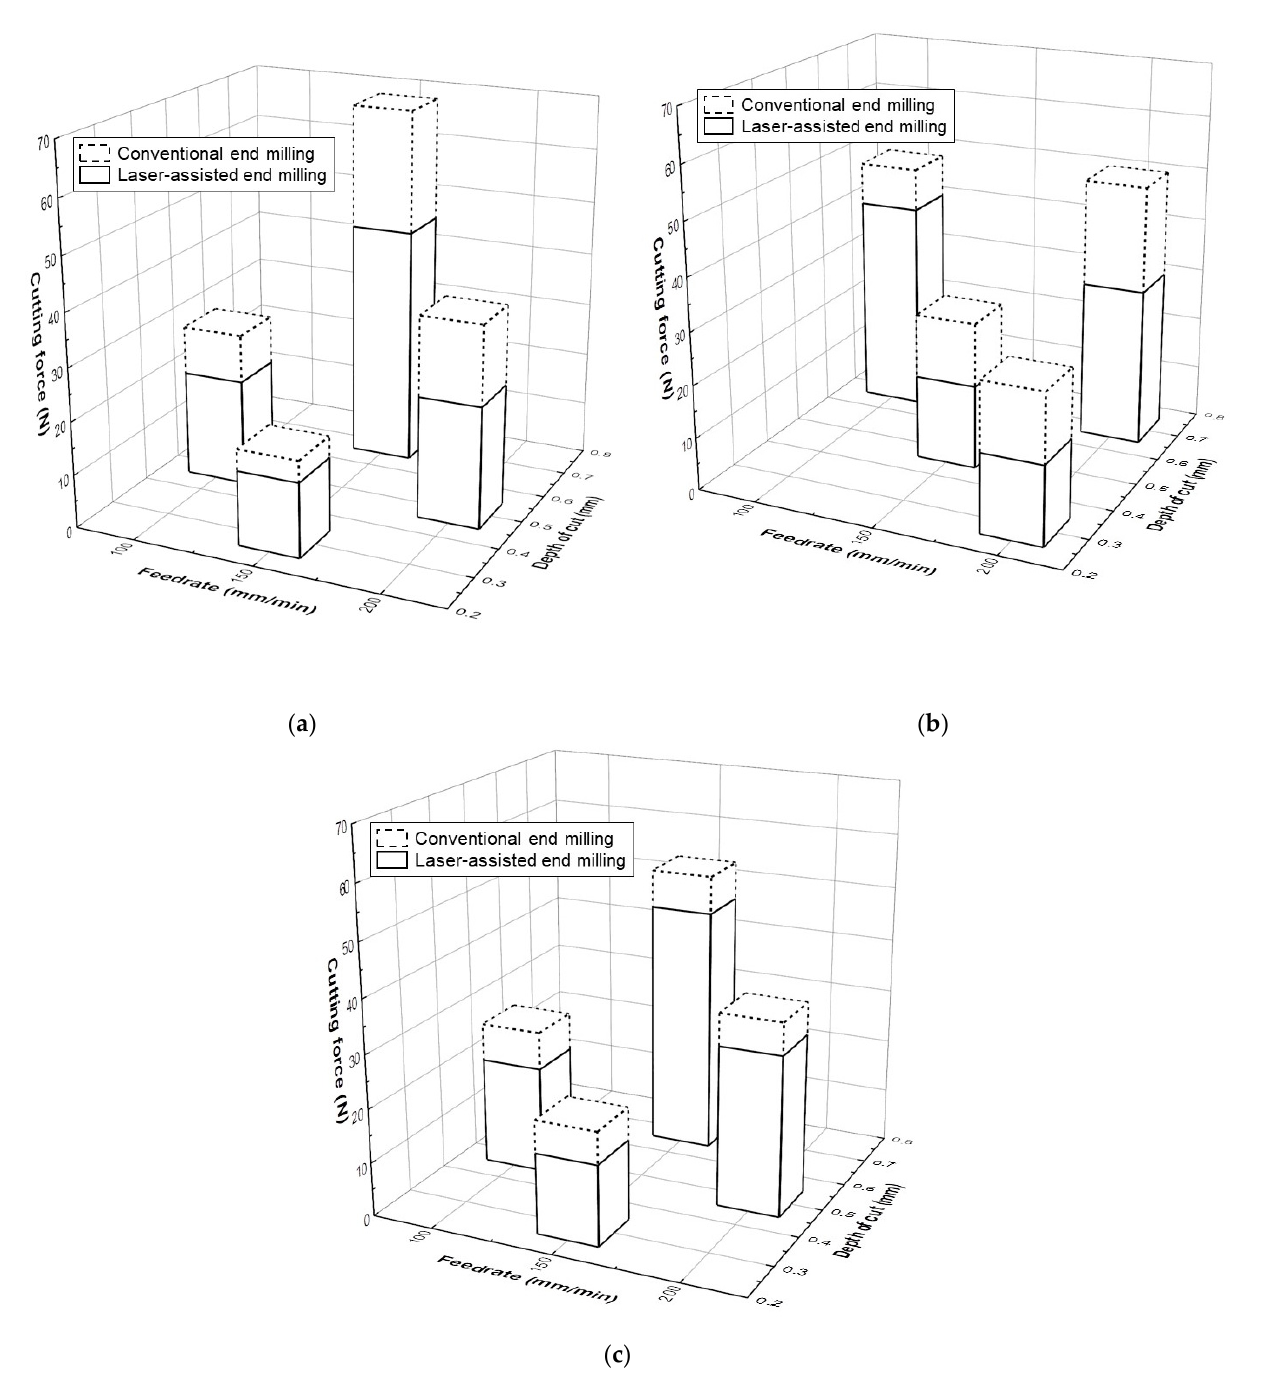
Figure 11. Effect of federate (100, 150, 200 mm/min) and depth of cut (0.3, 0.5, 0.7 mm) parameters on cutting forces: ( a ) at spindle speed of 7000 RPM; ( b ) at spindle speed of 5000 RPM; ( c ) at spindle speed of 3000 RPM.